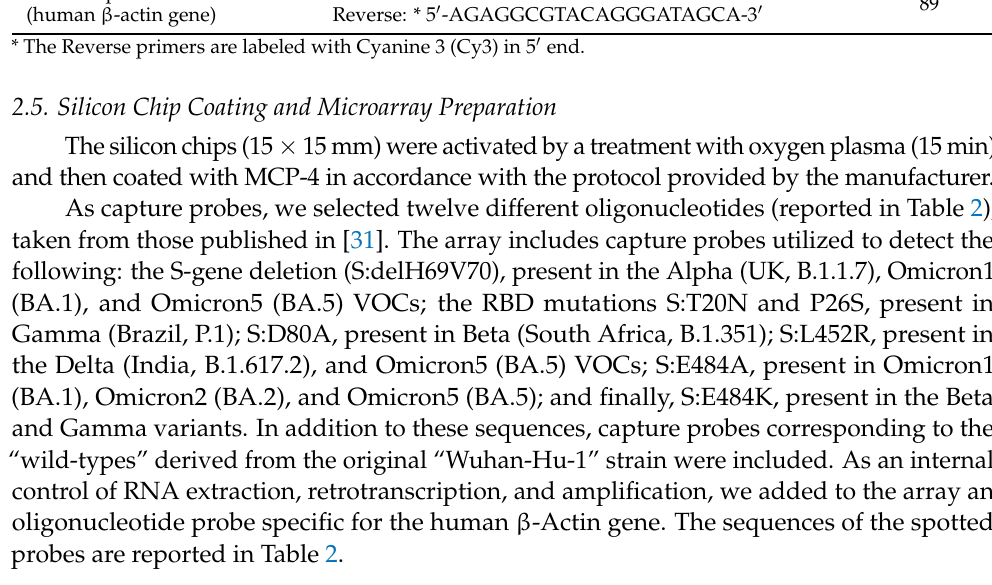
Table 2. Sequences of spotted probes and